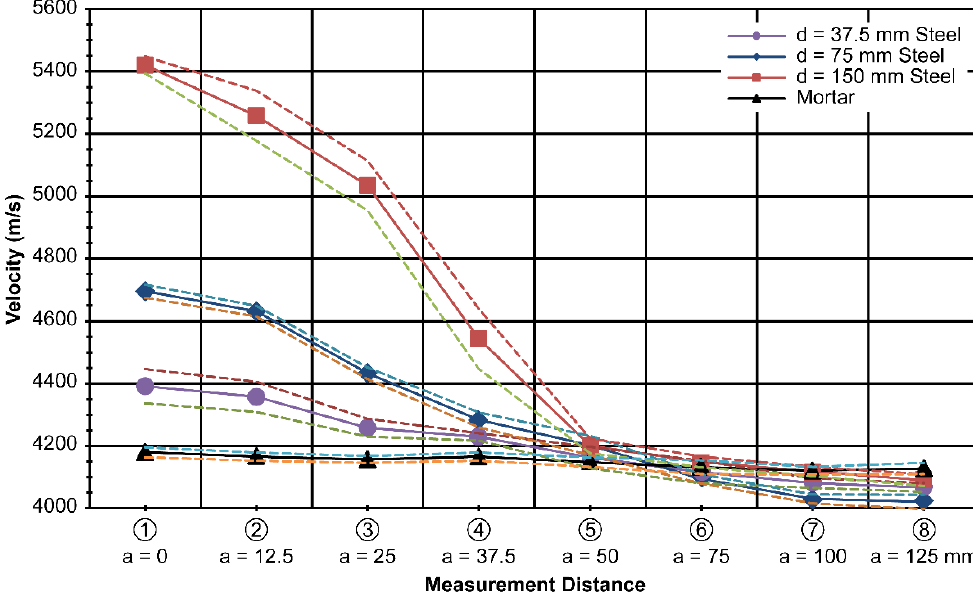
Figure 9. Measured velocity with varying depth (d)at t = 20 mm and h = 150 mm.